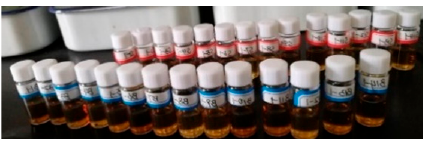
Figure 3. GPC samples.